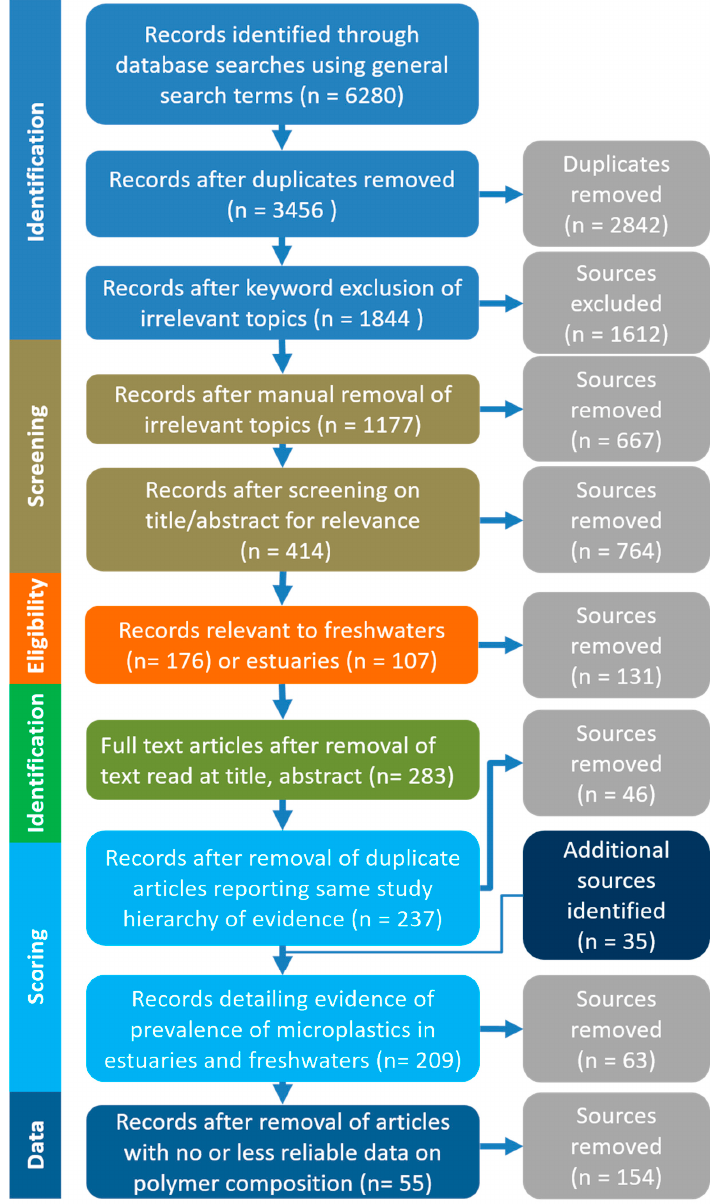
Figure 1. Map of evidence identified as relevant to this systematic